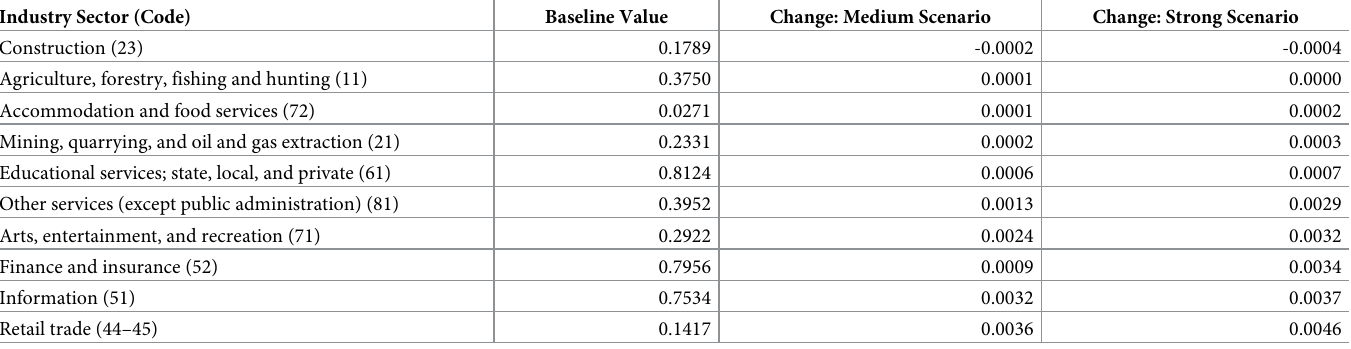
Table 12. Projected changes in fraction of jobs that can be performed remotely by 2-digit industry sector.